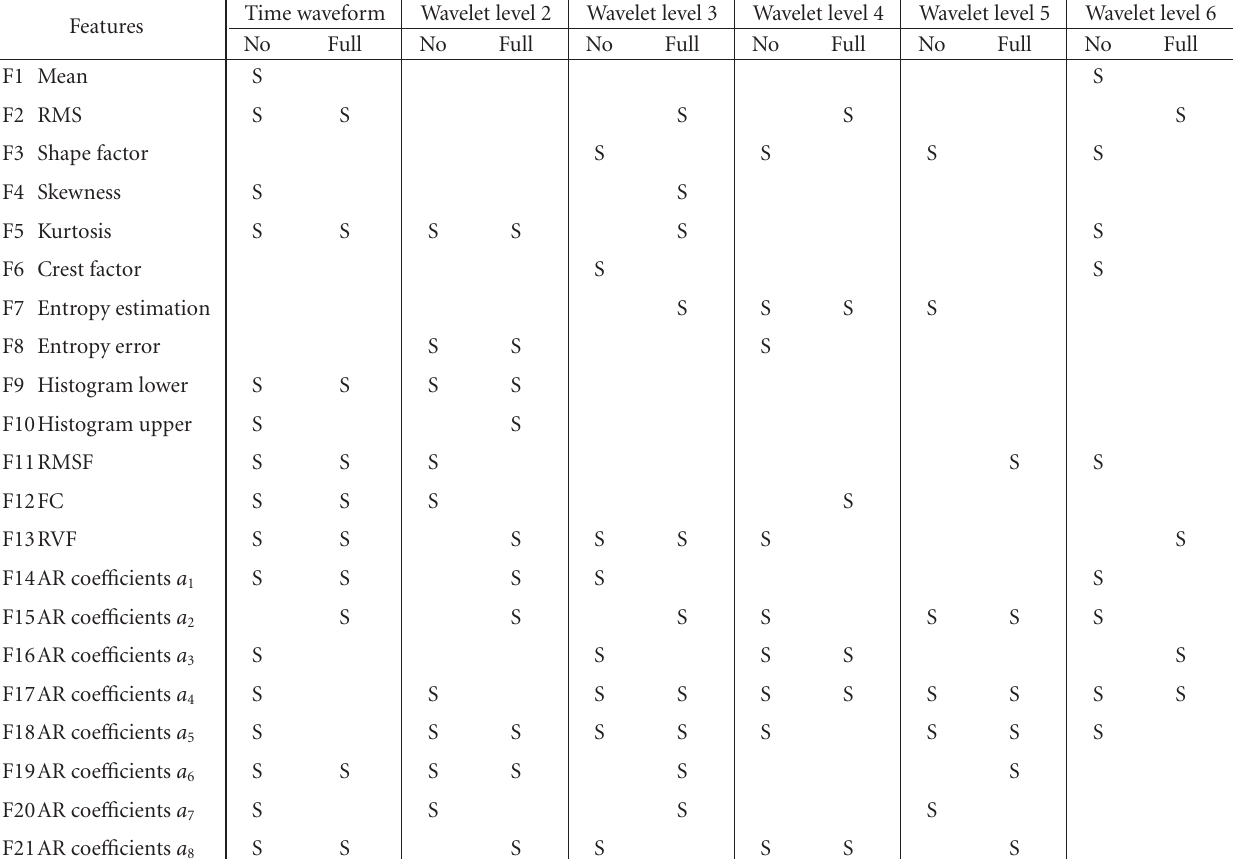
Table 6: Feature selection results using GA under no-load and full-load conditions. Symbol “S” represents selected feature.